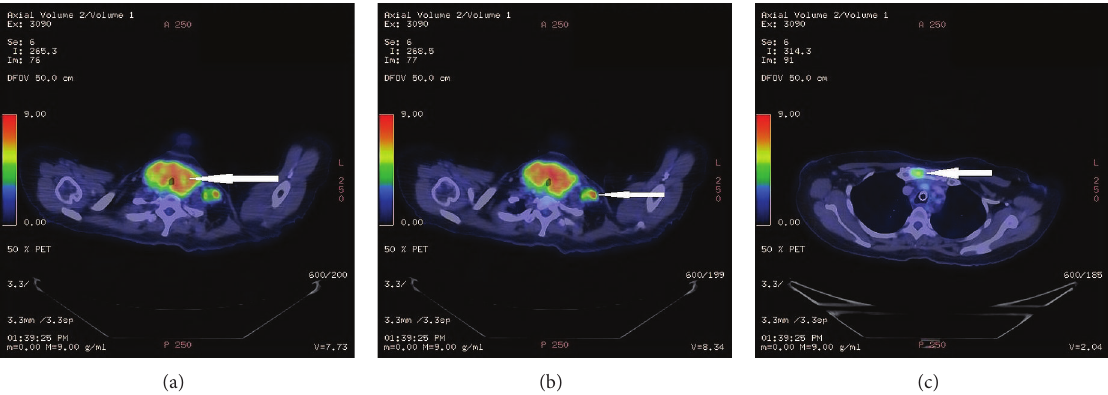
Figure 1: PET-CT scan showing (a) hypermetabolic enlarged thyroid gland, (b) hypermetabolic left cervical lymph node, and (c) hyperme- tabolic focus in right side of manubrium (indicated by arrows).